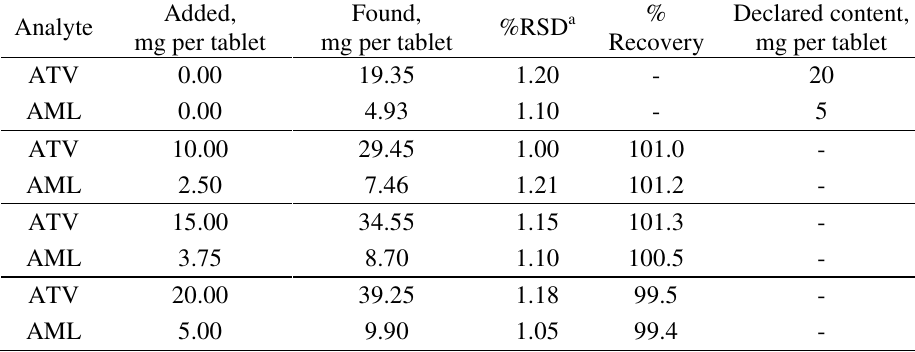
Table 3. Analyses of amostatin tablet from Razak